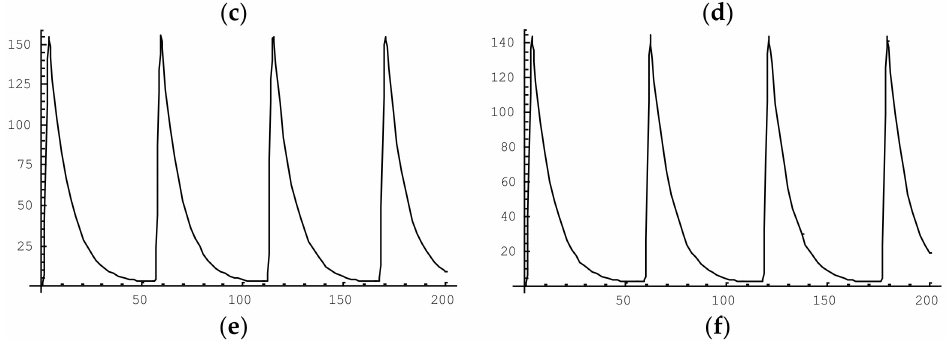
Figure 8. Diagram of the simulation under light irradiation; the six graphs represent oscillation simulation diagrams for different light